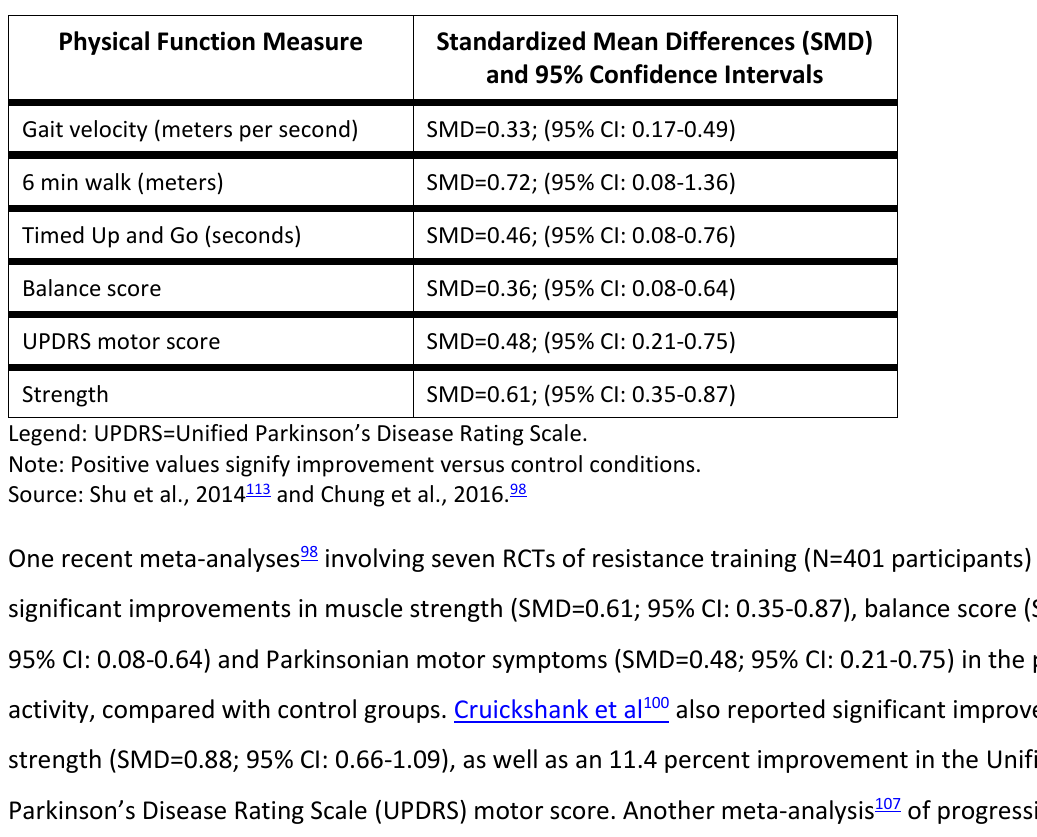
Table F9-4. Representative (Pooled) Effect Sizes for Physical Activity and Physical Function for Individuals with Parkinson’s